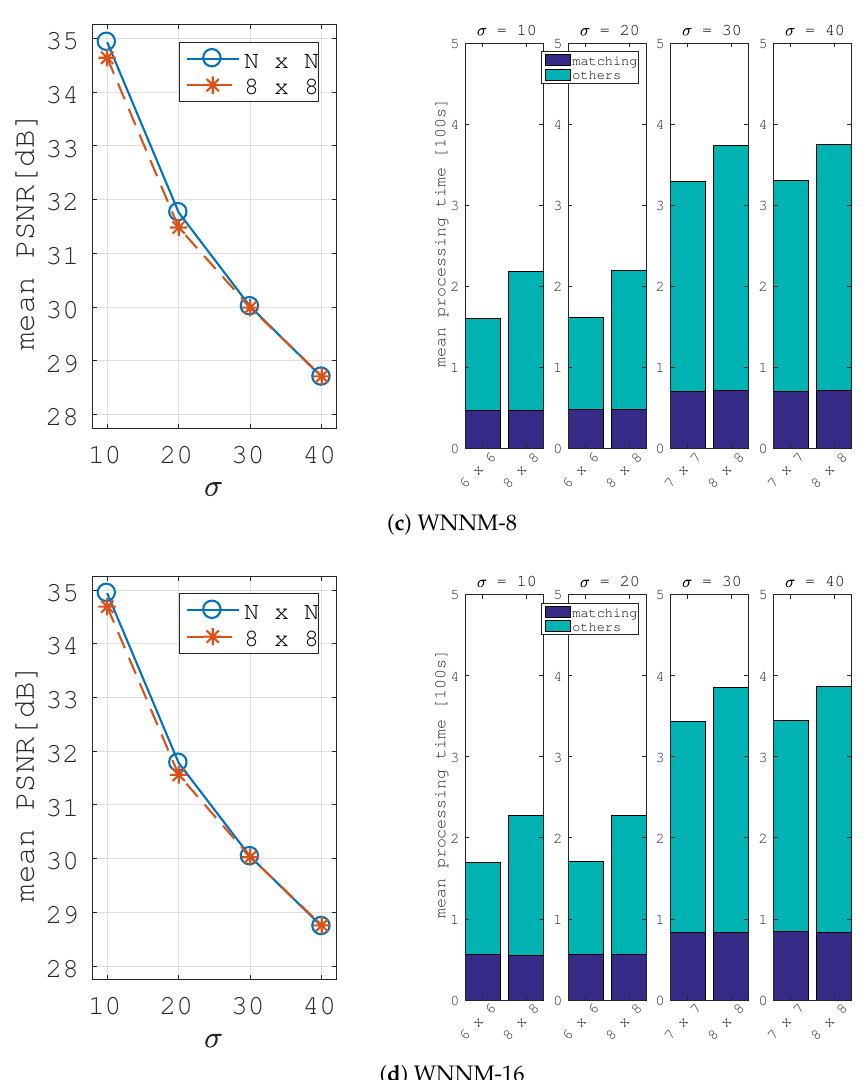
Figure 12. OTSHT vs. the 8 × 8 OHT. Mean PSNR and mean processing time of WNNM- K in different noise levels. In the chart, 8 × 8 denotes OHT; otherwise,